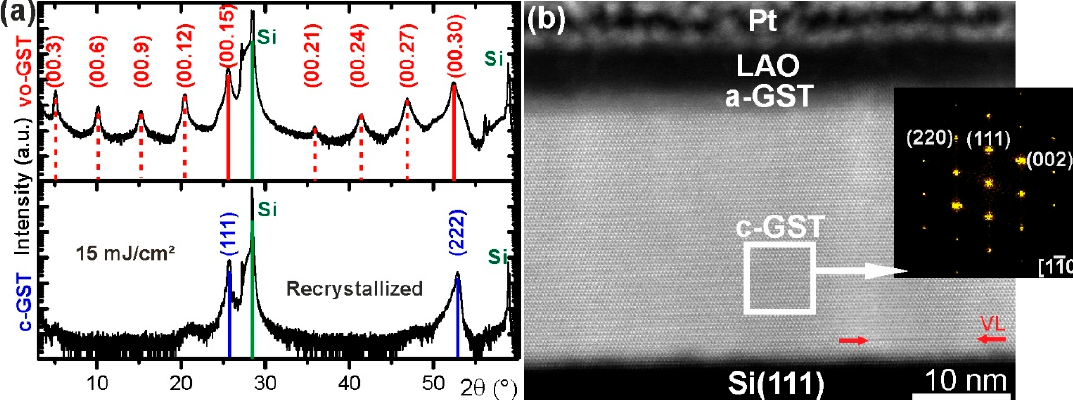
Figure 6. ( a ) XRD ω− 2 θ pattern of an epitaxial vo-GST thin film before (upper pattern) and after (lower pattern) irradiation with a single ns-laser pulse of a fluence of 15 mJ/cm 2 . The pattern of as-deposited vo-GST thin film shows superstructure reflections (vacancy layer peaks) marked by red dashed lines beside the main reflections marked by continuous red lines. The continuous blue and green lines mark (111) lattice planes in the c-GST and Si substrate, respectively. ( b ) HAADF-HRSTEM image of the laser irradiated thin film. Red arrows indicate a remaining VL. The inset shows FFT pattern, confirming the formation of the c-GST phase.